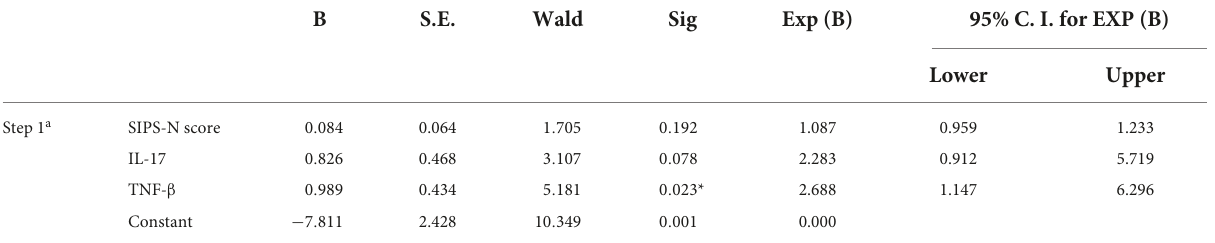
TABLE 4 The effects of N-scores, IL-17, and TNF- β levels on the conversion of psychosis. B